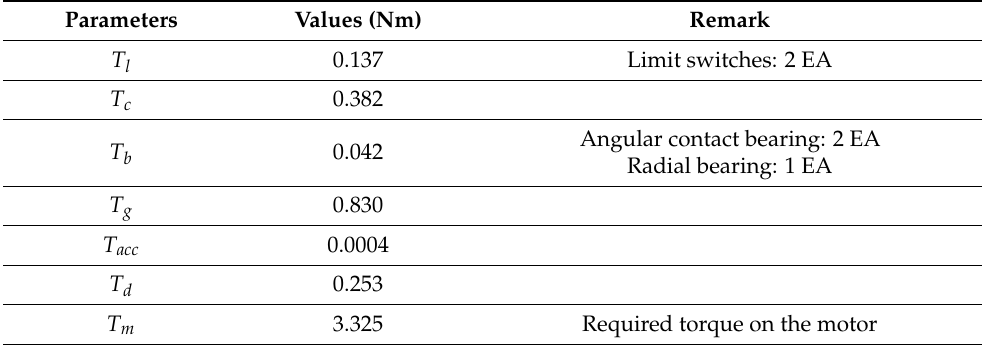
Table 1. Torque budget estimation results for tilting mirror calibration mechanism.